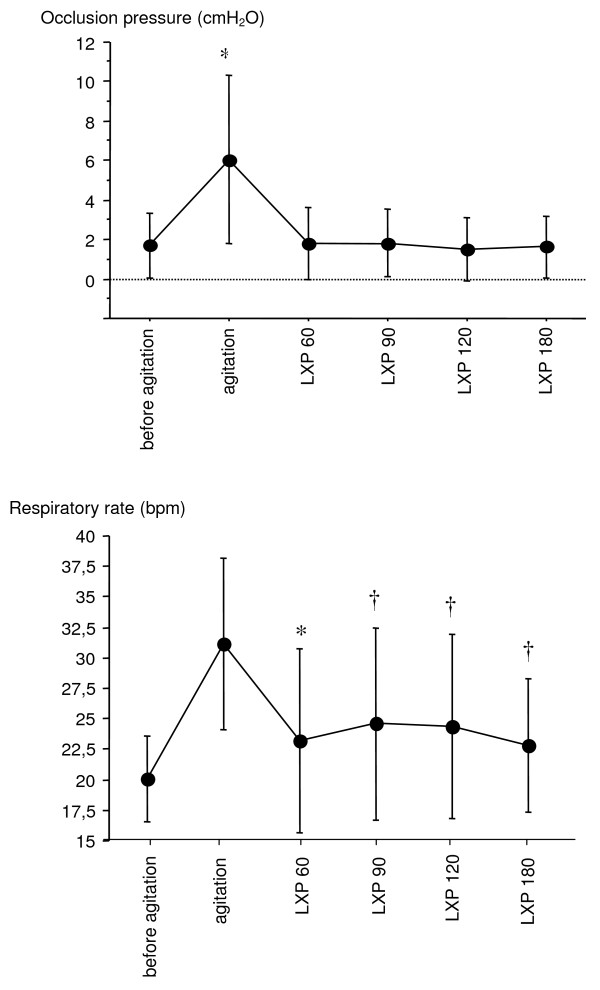
Breathing-pattern scores before agitation, at the time of agitation, and at 60, 90, 120, and 180 minutes after loxapine (LXP) administration. The dramatic increase in both respiratory rate and P0.1 observed during agitation normalized after loxapine administration. Significance of differences: *P < 0.0001 versus all other conditions; † P < 0.05 versus values observed before agitation.